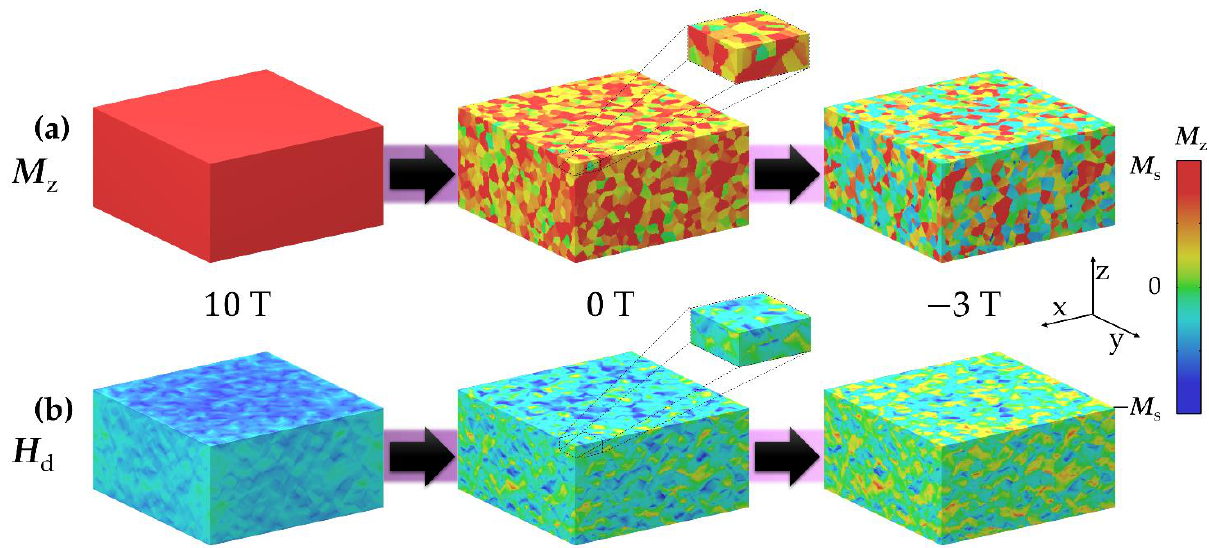
Figure 3. ( a ) Magnetizations and ( b ) demagnetizing fields of the model magnet at 10 T (saturation), 0 T (remanent state), − 3 T (during reversal). Red and blue colors correspond to M s and − M s , respectively.